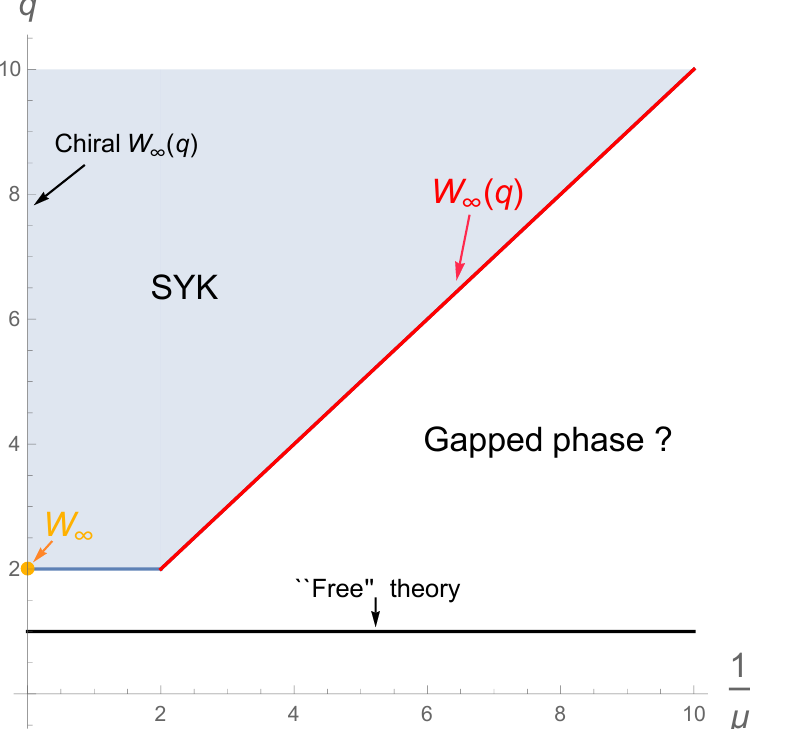
Figure 13. An illustration of the moduli space of our model. In the shaded region the model has SYK-like behavior. In the two limits, which are on the boundary of the shaded region, one observe emergent higher-spin symmetries. At q = 1, the interaction is quadratic, which can be regarded as a free \mass" term and the model is essentially free. Outside the shaded region the Fourier transform in (2.36) diverges. As suggested in [101] one probably has to turn on a negative mass counterterm to reach another (cid:12)xed point. This is an indication that in this region the model might be